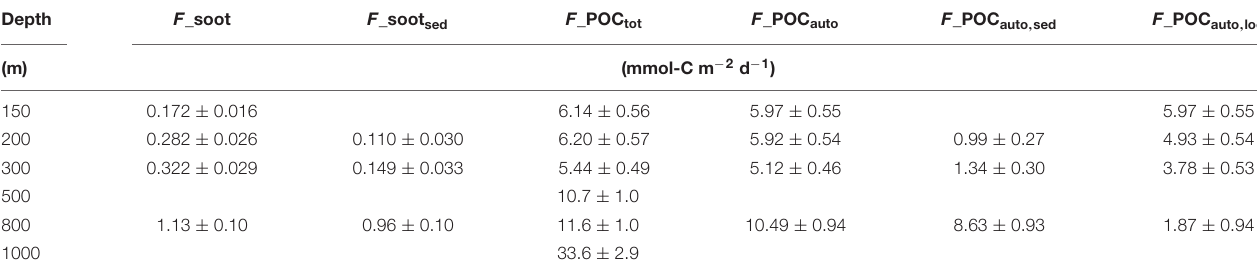
TABLE 2 | The export fluxes of total POC ( F _POC tot ) and soot ( F -soot), autochthonous POC (i.e., soot-excluded POC, F _POC auto ), sediment contributed soot flux ( F _soot sed ) and autochthonous POC ( F _POC auto , sed ), and autochthonous POC contributed by local ecosystems in the euphotic zone ( F _POC auto , loc ).